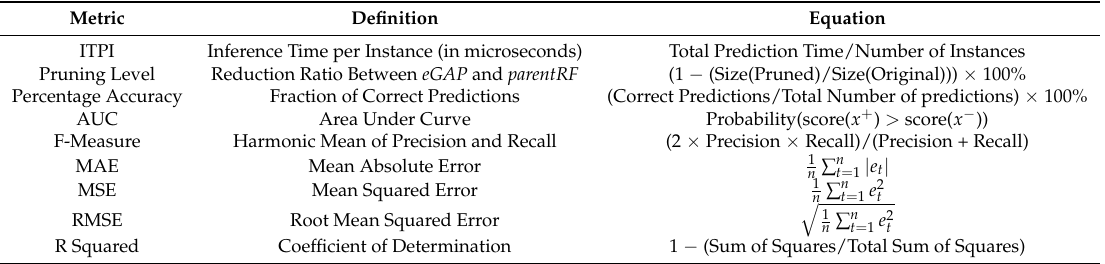
Table 4. Metrics